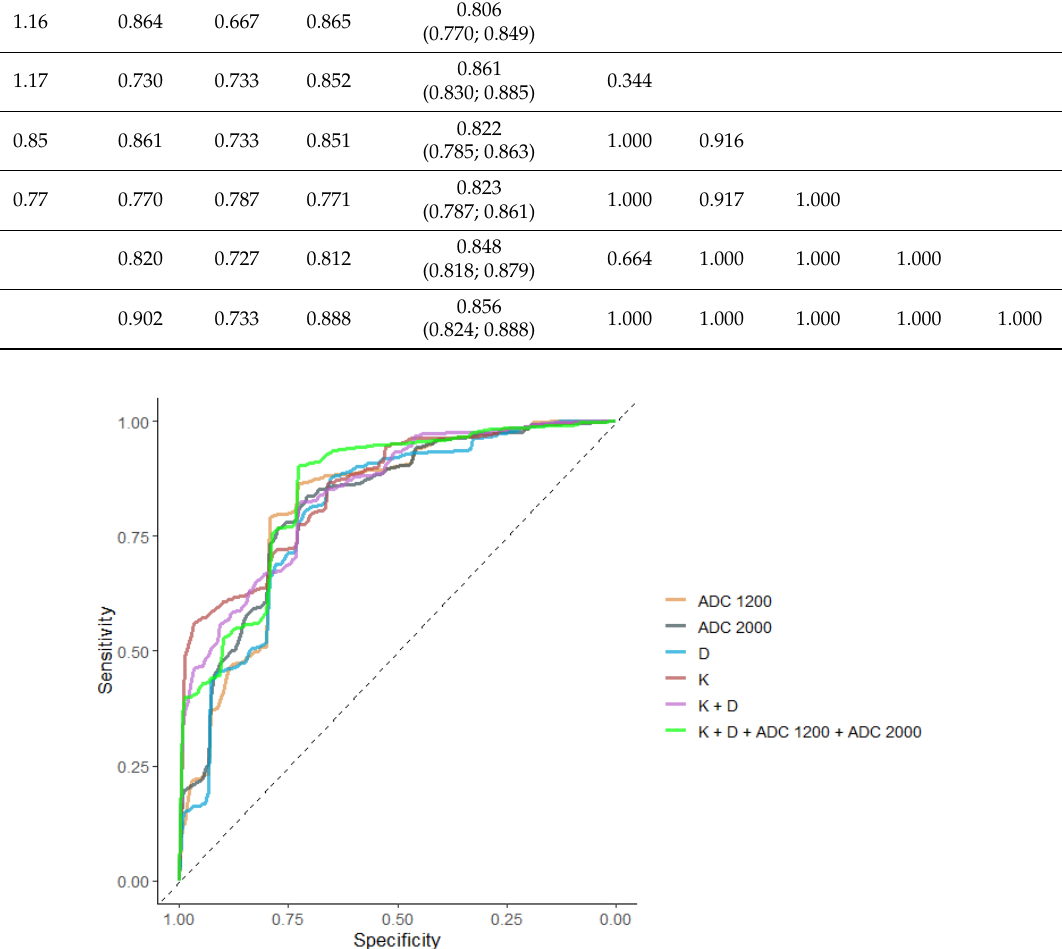
Figure 5. ROC curves of the performance of D app , K, ADC 1200 and ADC 2000 , K + D, and K + D + ADC 1200 + ADC 2000 for differentiating GS ≤ 3 + 3 and GS ≥ 3 + 4 tumors located in either PZ or TZ. The models do not differ significantly.